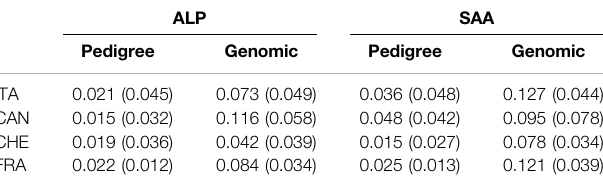
TABLE 5 | Average and standard error of pedigree-based and genomic inbreeding within each country and breed for genotyped